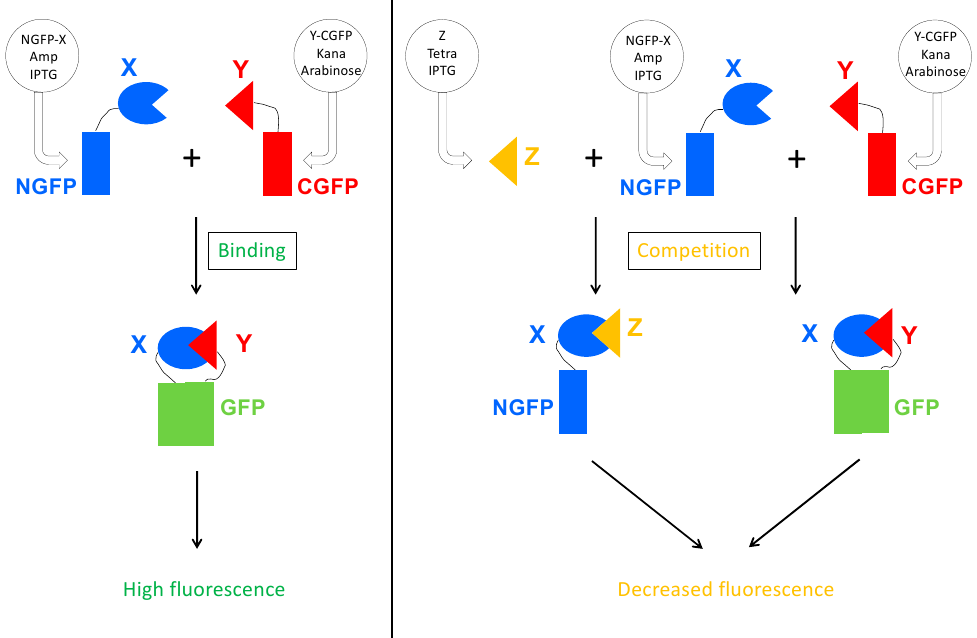
Figure 3. Principle of the Split-GFP-based competition assay. On the left panel is represented the split-GFP reassembly assay. Two proteins X and Y known to interact are respectively fused to the N-terminal (NGFP) and to the C-terminal part of GFP (CGFP), and co-expressed in E. coli by their respective plasmid. The plasmid coding for NGFP fusion confers ampicillin resistance and expression is induced by IPTG. The plasmid coding for CGFP fusion confers kanamycin resistance and expression is induced by arabinose. When protein X binds to protein Y, their two GFP halves are brought together and reconstitute the functional GFP. On the right panel, a competitor Z is co-expressed with NGFP-X and Y-CGFP. The plasmid coding for Z confers tetracycline resistance and Z expression is induced by IPTG. Z binds to X, which reduces the amount of NGFP-X fusion protein available for binding to Y-CGFP, and hence reduces the amount of fluorescence produced by the